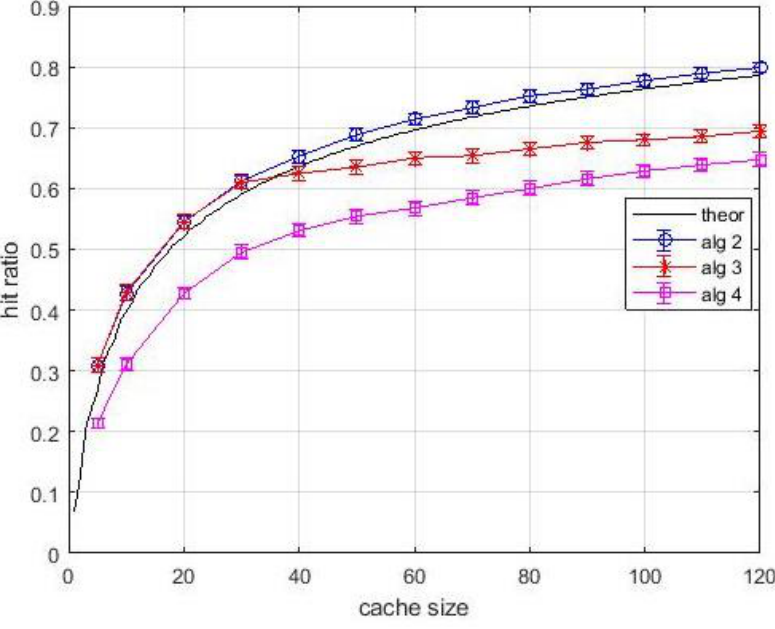
Figure 11. Hit ratio, case 3.